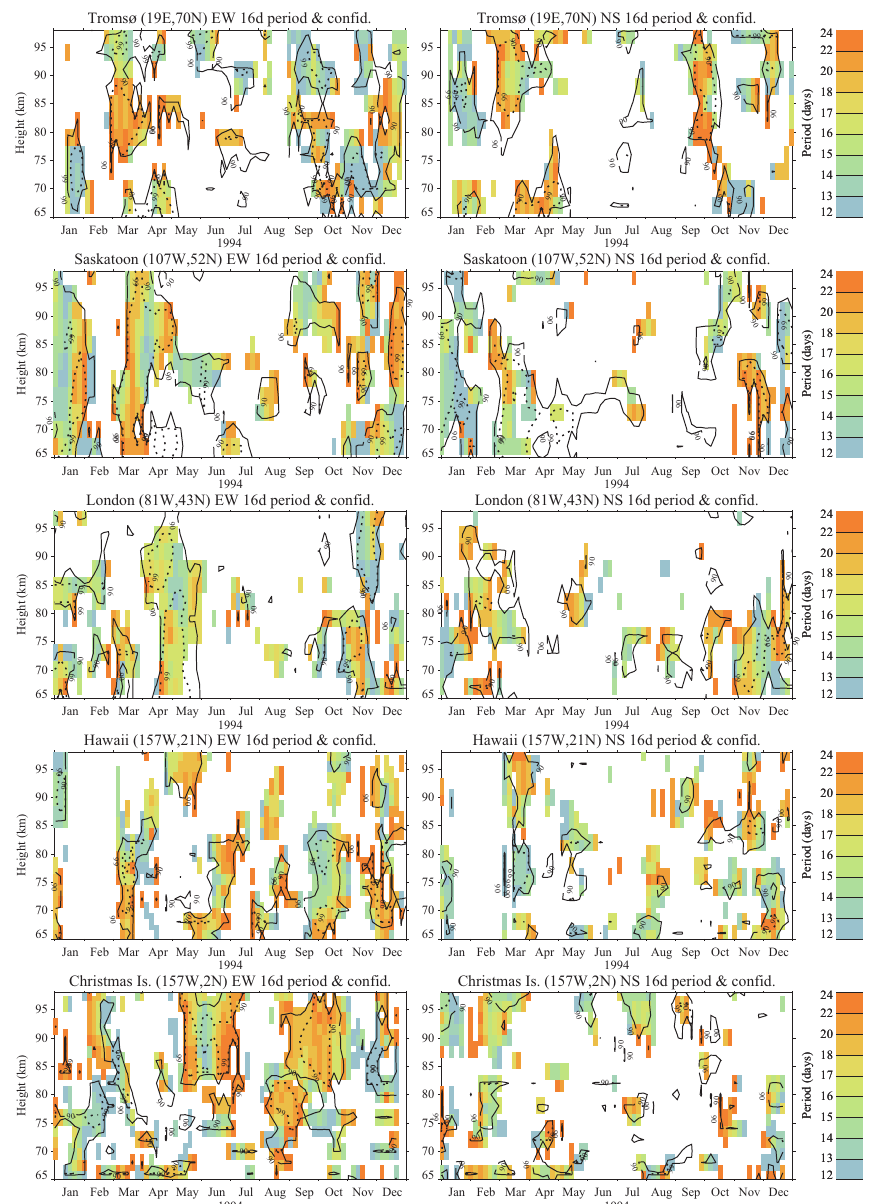
Fig. 6. Same as Fig. 5 but for the 16-day wave periods (colour bars) and the confidence levels (line contours) corresponding to the wave amplitudes shown in Fig. 5. Two confidence levels are drawn with dashed lines (99%) and solid lines